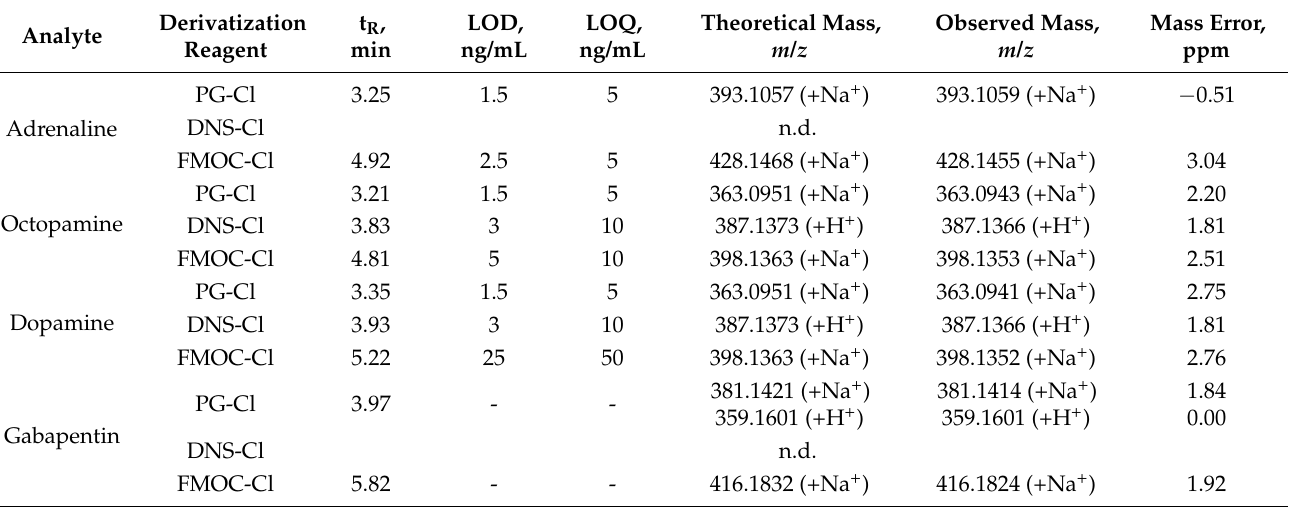
Table 4. Comparison of sensitivities obtained with different derivatization